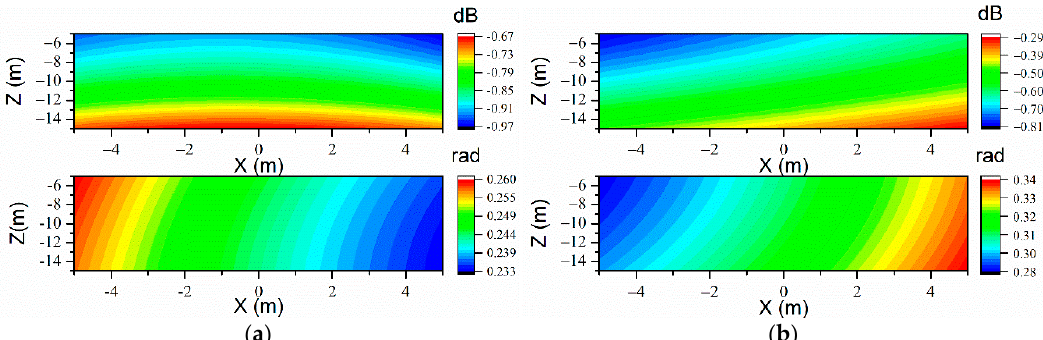
Figure 16. The sound prediction errors of CMESM on the prediction plane at the frequency of 71 Hz when 90 measurement points are used (optimized with EFI). ( a ) Free field (upper: p E ; lower: ϕ E , L 1 = 66 ); ( b ) h U = 0.2 m (upper: p E ; lower: ϕ E , 𝐿1 = 75 ).